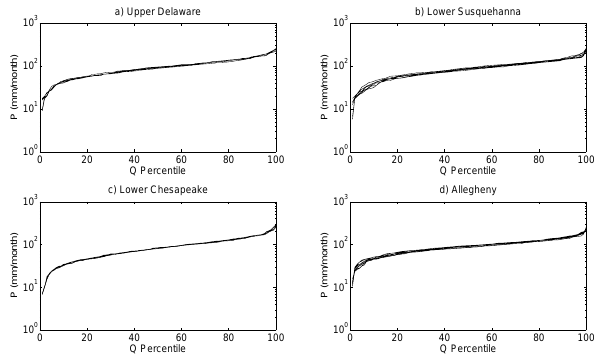
Fig. 2. Precipitation Duration Curves of all the catchments within (a) Upper Delaware, (b) Lower Susquehanna, (c) Lower Chesa- peake, and (d) Allegheny